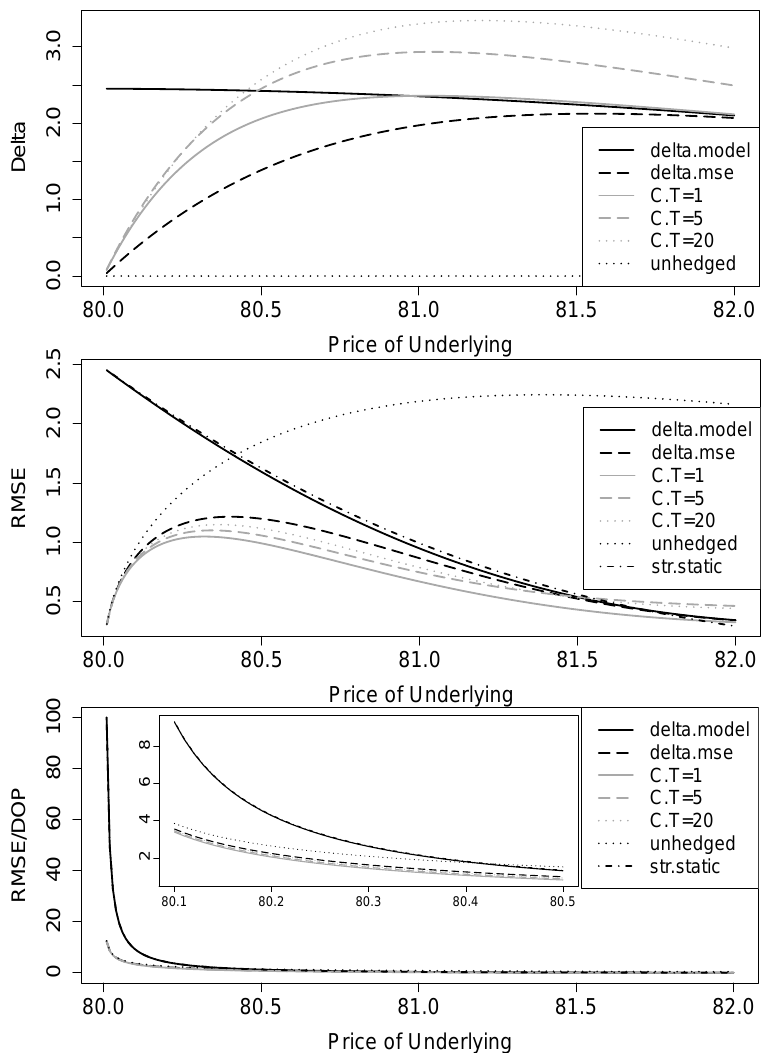
Figure 2. Black–Scholes model with discrete hedging in continuous time: deltas, absolute and relative root mean squared hedging errors. Hedging object is a down-and-out put with K = 100, B = 80, and T = 20 days; the hedging period is ∆ t = 1 day. The hedging strategies are: standard Black–Scholes delta (delta.model), MSE delta using the underlying (delta.mse), MSE delta using vanilla calls with time to maturity of 1 (C.T = 1), 5 (C.T = 5), and 20 (C.T = 20) days, strike-spread static hedging (str.static), and no hedging